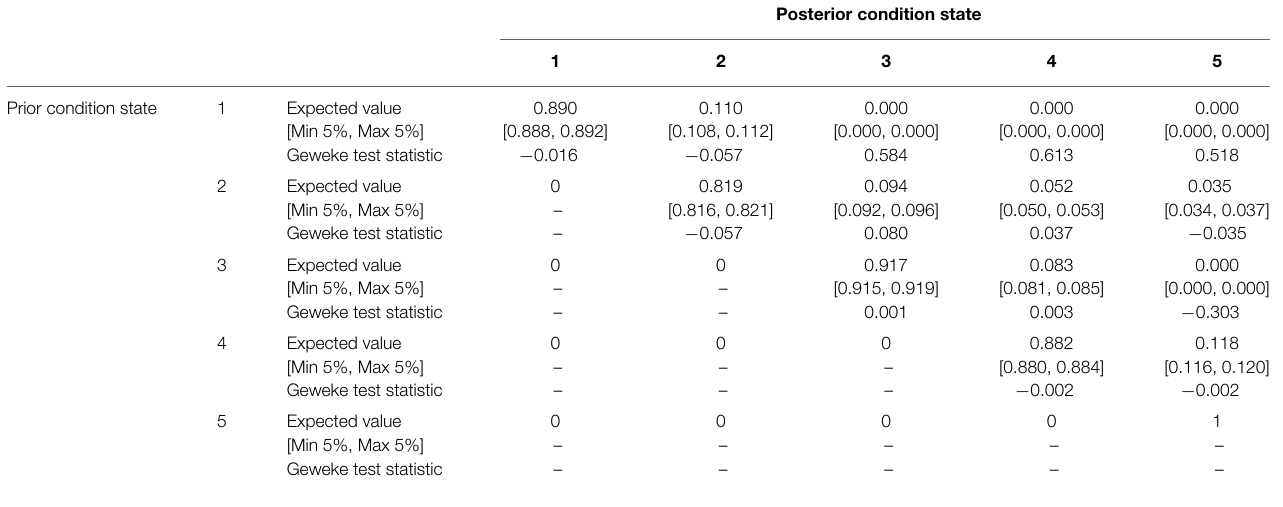
Posterior condition